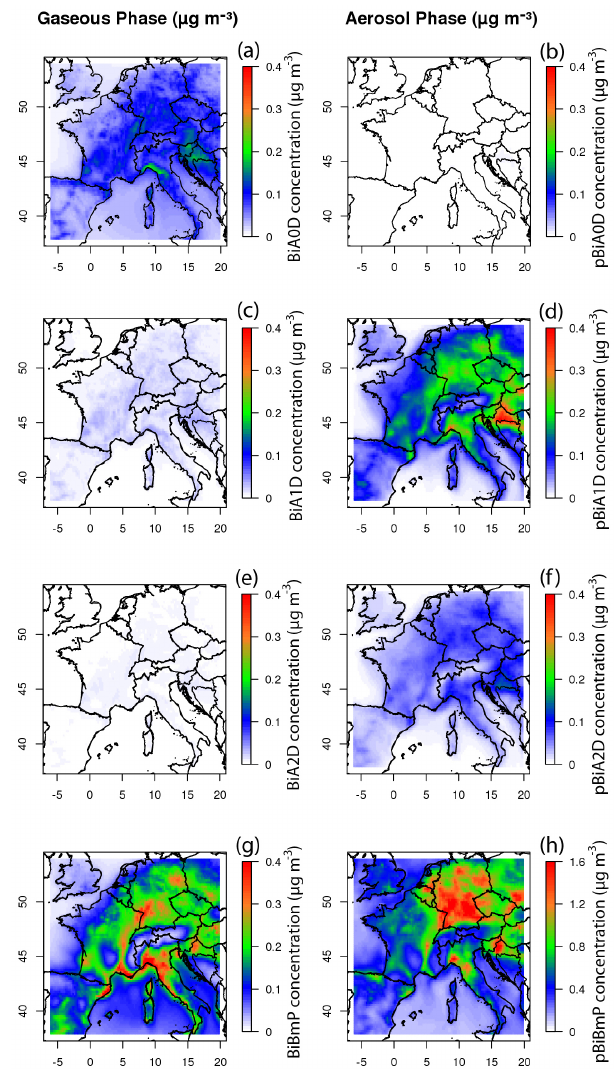
Figure 2. Mass concentration fields of BiA0D (a, b) , BiA1D (c, d) , BiA2D (e, f) and BiBmP (g, h) in the gas (left) and particulate (right) phases, modeled by CHIMERE and averaged over 20 July– 3 August